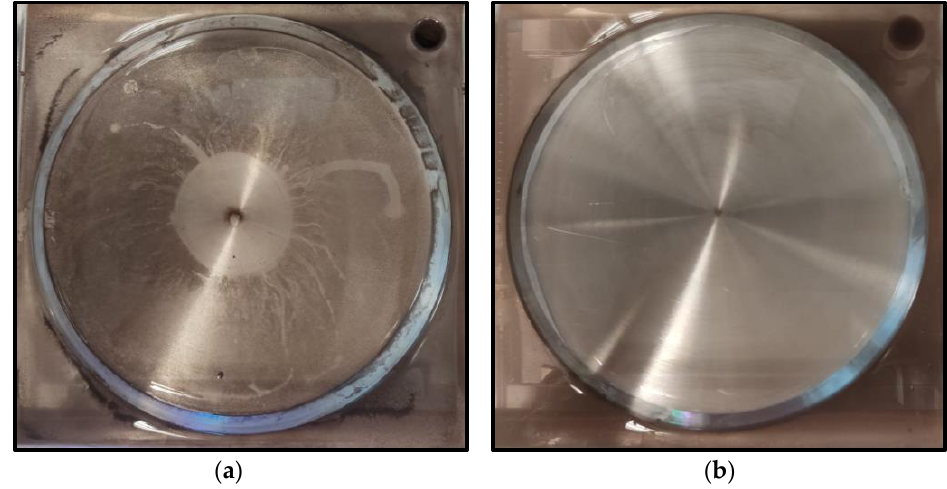
Figure 11. Heated plate surface after being jet impinged ( a ) without SDBS added to hybrid nanofluids; ( b ) with SDBS added to hybrid nanofluids.